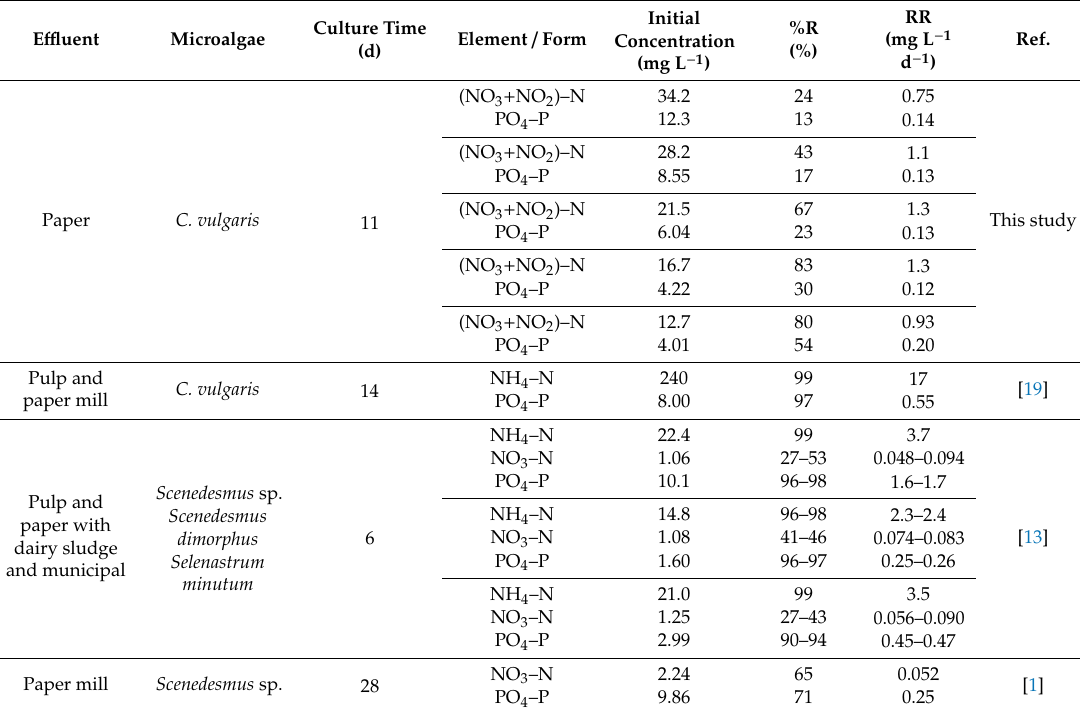
Table 3. Comparison between nutrients removal e ffi ciencies (%R, in %) and average removal rates (RR, in mg L − 1 d − 1 ) obtained in this study and other studies reporting microalgal growth in e ffl uents resulting from pulp and paper